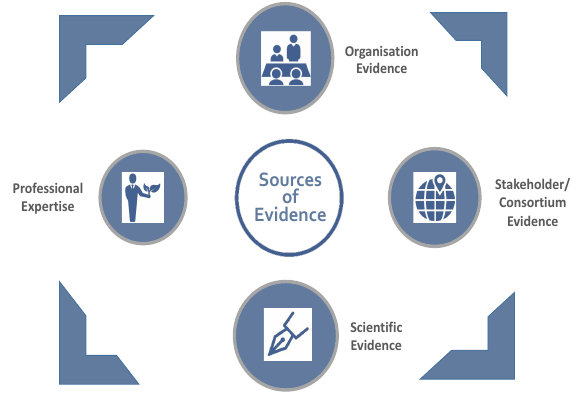
Figure 4. Sources of